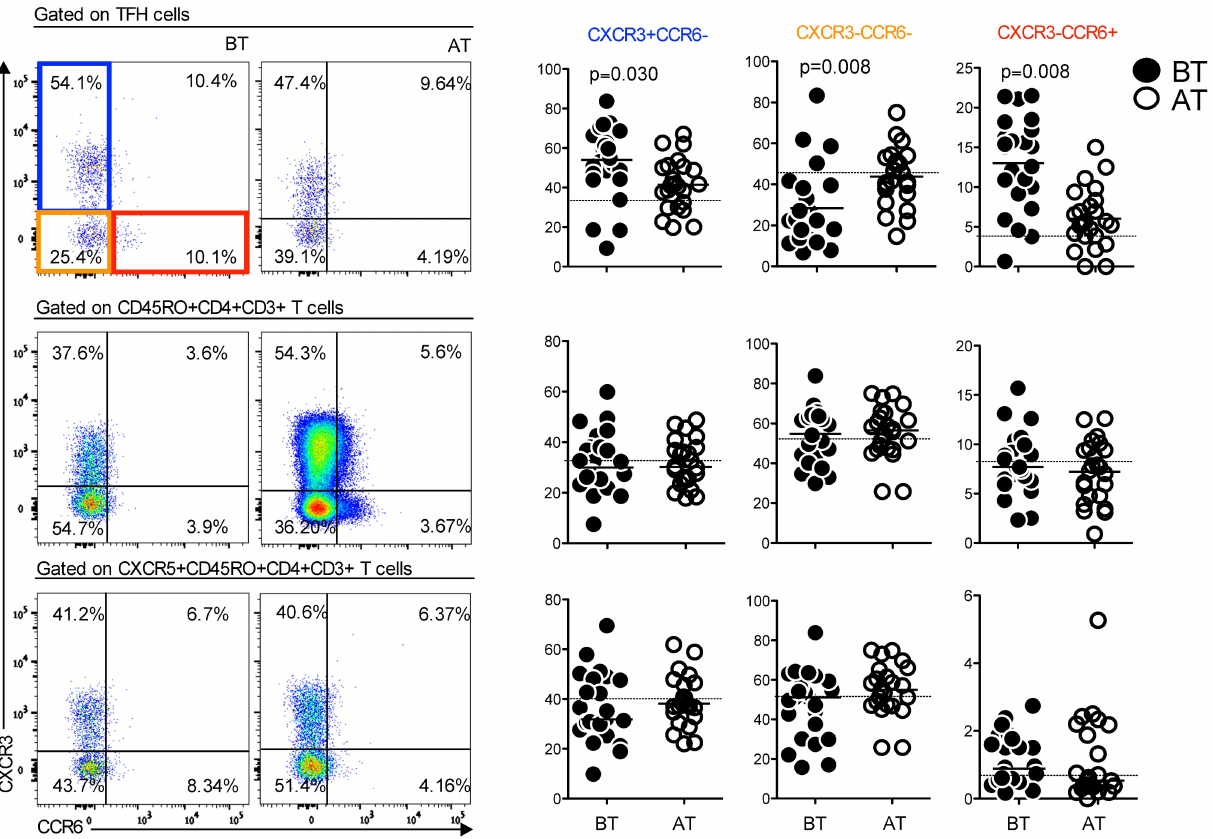
Fig 3. Distribution of CXCR3 and CCR6 expressing cells is altered in the Tfh cells compartment during Plasmodium vivax infection. PBMC from P . vivax -infected patients were analyzedex vivo (n = 24) duringacute malaria episode(BT) and 30–45 days after treatment (AT). All the T cell subsets were analyzedafter gating on live CD3 + cells. Representative density plots showing frequency of Tfh cells (PD- 1 + ICOS + CXCR5 + CD45RO + CD4 + CD3 + cells), CD45RO + CD4 + and CXCR5 + CD45RO + CD4 + T cells expressing or not CXCR3 and CCR6 from a single P . vivax -infected patient. Scattered plots showingthe percentage of T cell subsets in P . vivax -infected patients before (BT) and after treatment (AT) expressingor not CXCR3 and CCR6. Lines represent median values of the given measurement in each group. Dotted lines represent healthydonors. p values are depicted in the